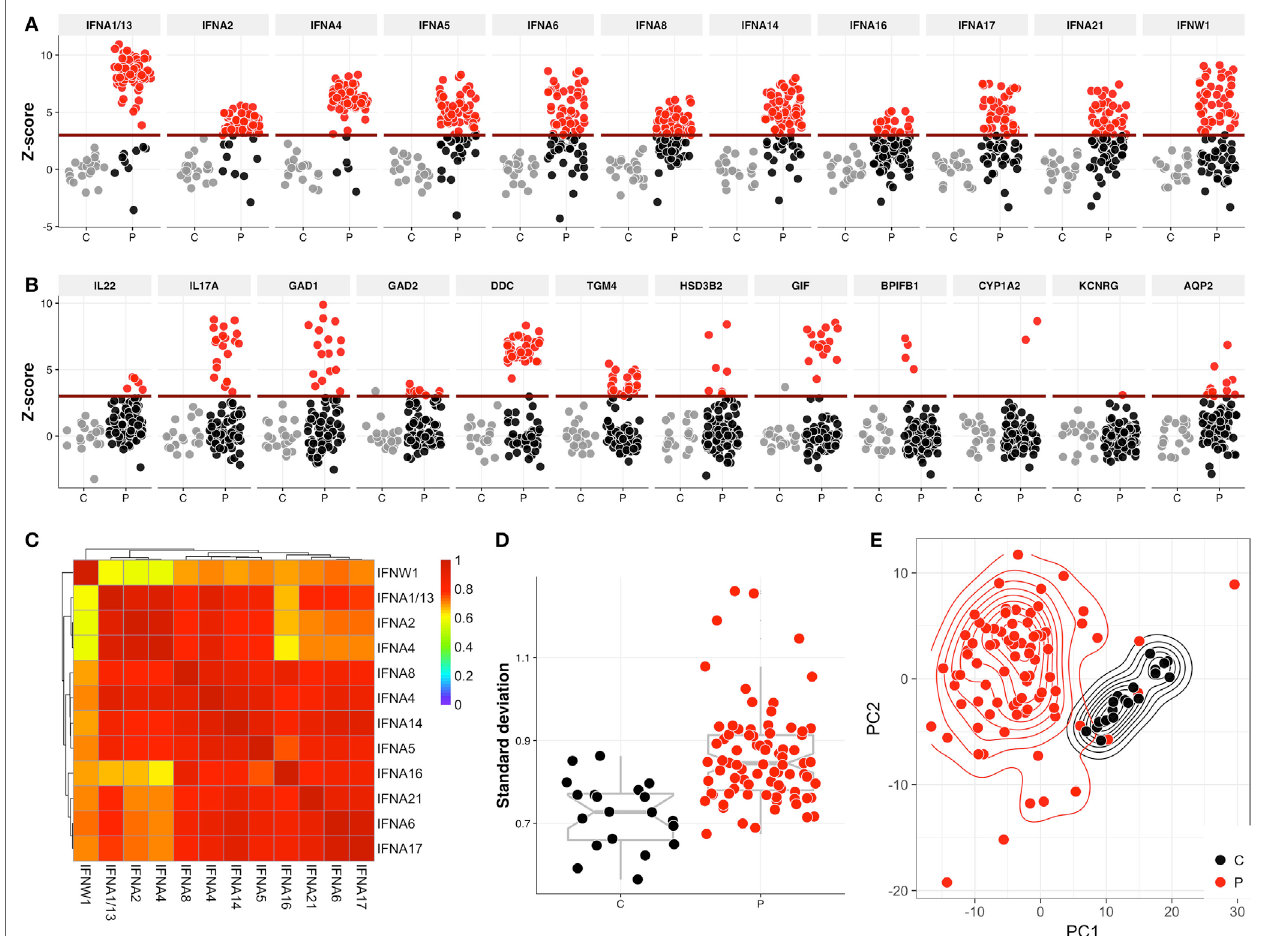
FigUre 1 | Protoarray reactivities to type I interferons (IFNs) and to known autoantigens. The reactivities to (a) type I IFNs and (B) known APECED autoantigens. The Protoarray signals are expressed as z -scores representing the number of SDs from the mean of combined control samples. Positive-negative discrimination level (dark red line) was set at z = 3. Red circles represent the samples with z > 3, gray circles are control samples. (c) Heatmap of correlation coefficients of type I IFN reactivities between each other. (D) Variation analysis of controls and patients—each dot on this figure represents a SD within sample over all Protoarray signals. Red circles represent patients (P) and black controls (C). Variance in patient samples are significantly higher ( p = 2.598e − 07) in comparison to control samples. (e) Principal component analysis plot of controls and patients. The first two principle components explain 35.8 and 11.5% of total variance, respectively. First 50 most common autoantibody reactivities were used in order to build this